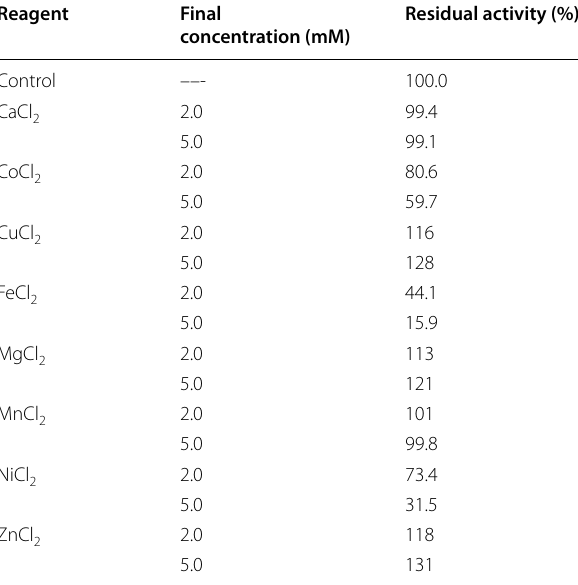
Table 2 Effect of divalent cations on